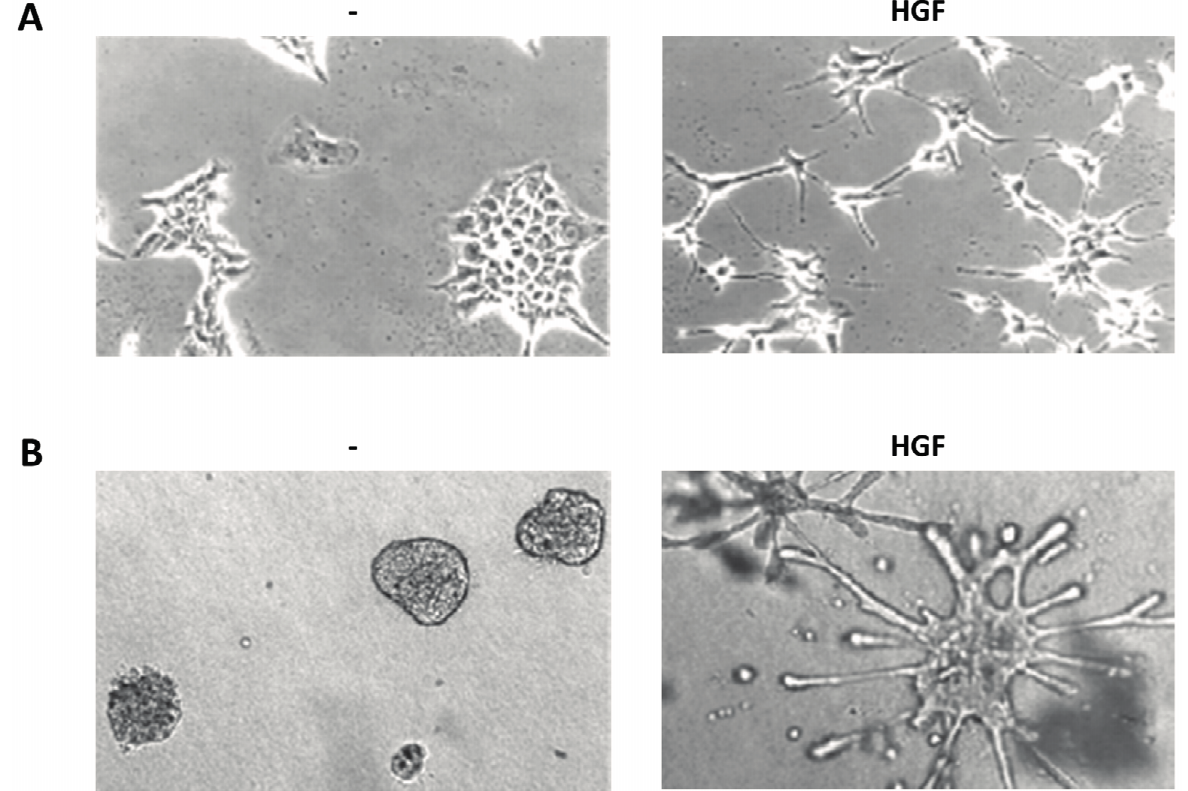
Figure 2. HGF biological assays. ( a ) Scatter assay. Mouse embryonic liver derived cells (MLP-29, [123]) cultured on plastic in presence or absence of HGF (5 U/mL, 24 h); ( b ) Branching morphogenesis assay. MLP-29 cells cultured in collagen gels in presence or absence of HGF (20 U/mL, 7